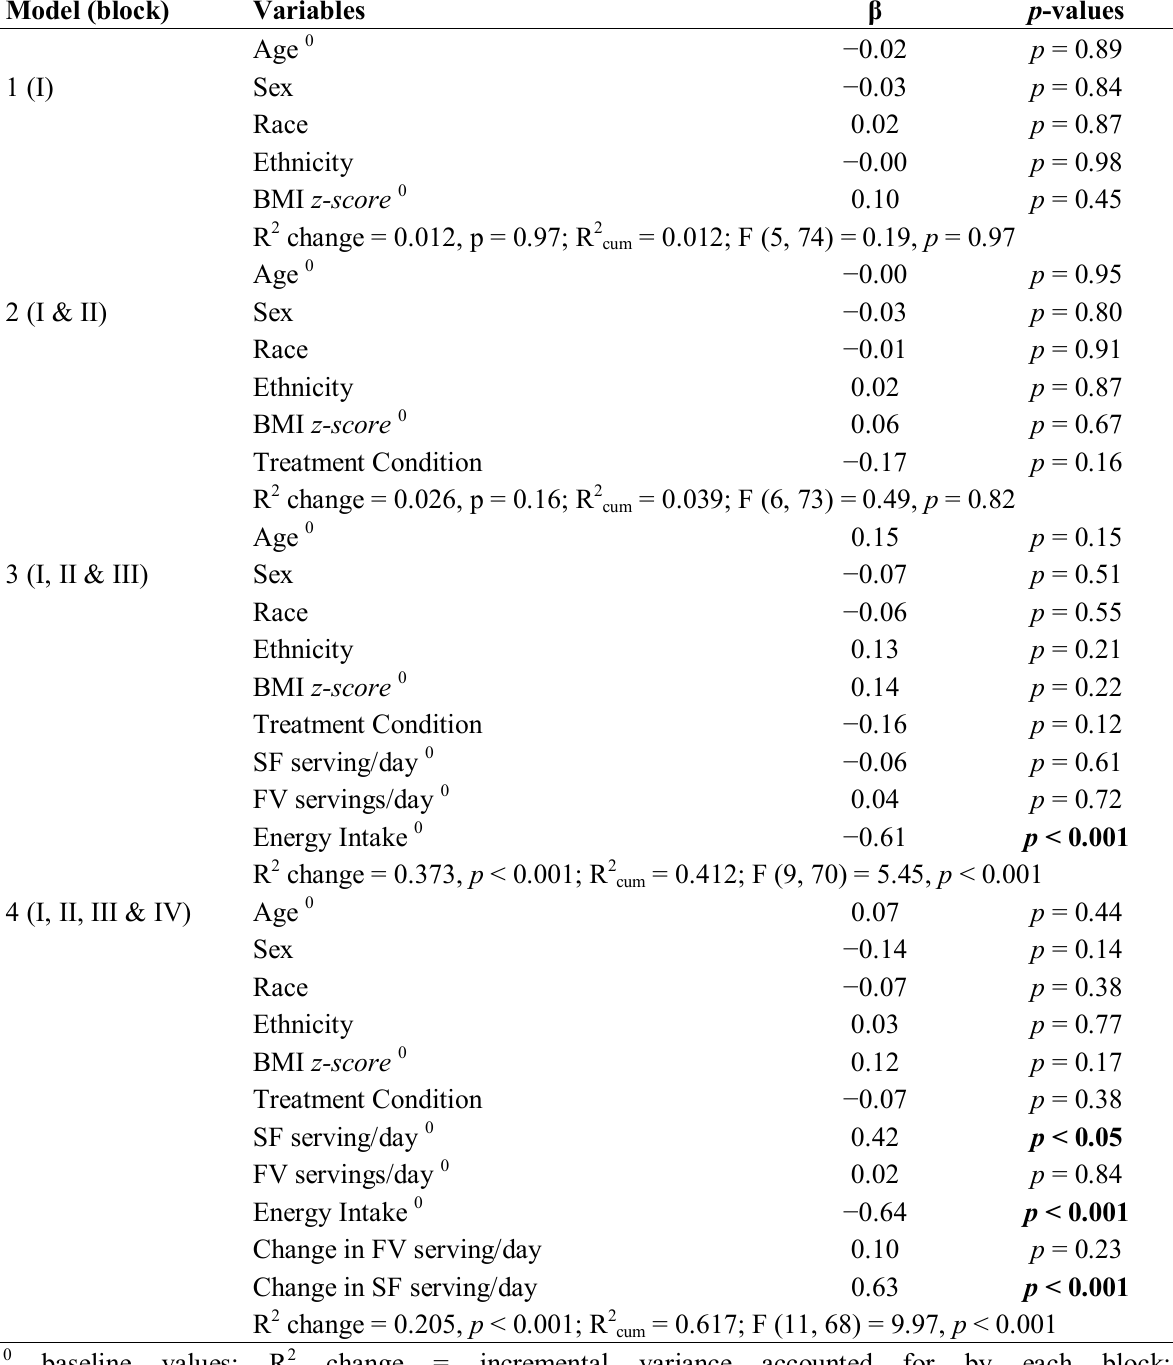
Table 3. Block linear regression models of baseline child characteristics, treatment condition, baseline dietary variables, change in fruit and vegetable servings per day and change in snack food servings per day on change in energy